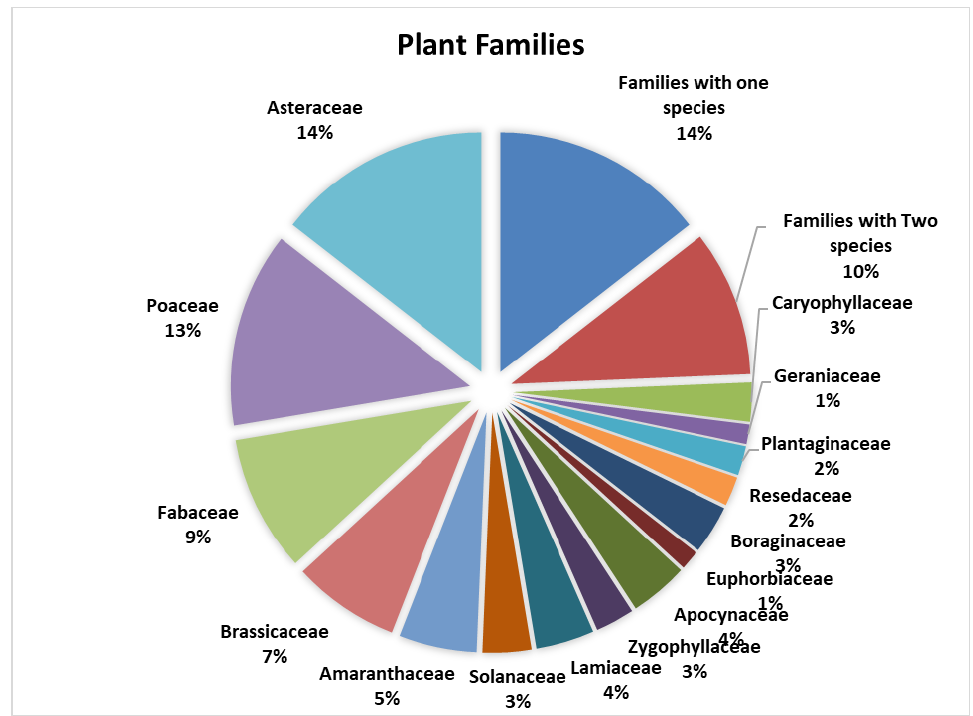
Figure 4. The proportional contribution of plant families in Jabal Al-Ward. Seven life form categories were observed in the current study. The most frequent group was the therophytes, with 92 species, followed by chamaephytes, which were identified as 55 different species. There were 22 species of hemicryptophytes. Thirteen species were cryptophytes and twelve species were identified as phanerophytes. Three species were helophytes and one parasitic species was recorded in the Jabal Al-Ward area. Percentages of each life form relevant to the total number of species are illustrated in Figure 5.